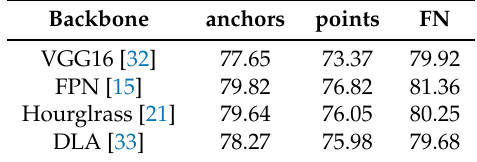
Table 3. Comparisons with different backbones on VOC dataset .